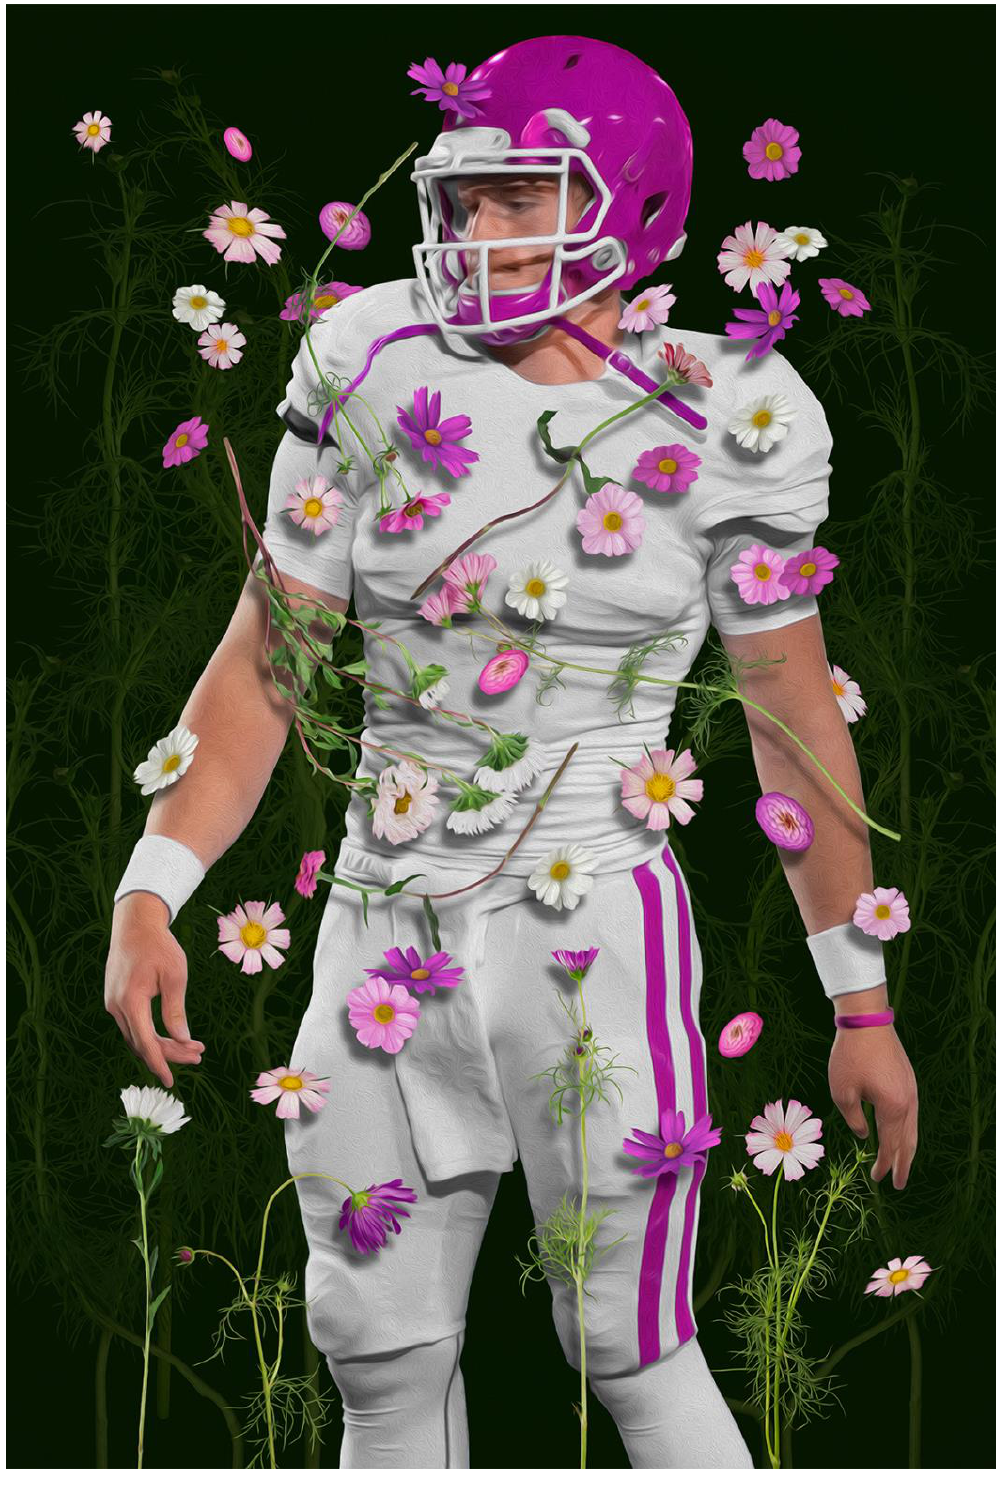
Figure 1 Nick Simko, Football (7) , 2018, Digital Composite Photograph, Inkjet Print on Paper, 60 ¾ x 41 ¾